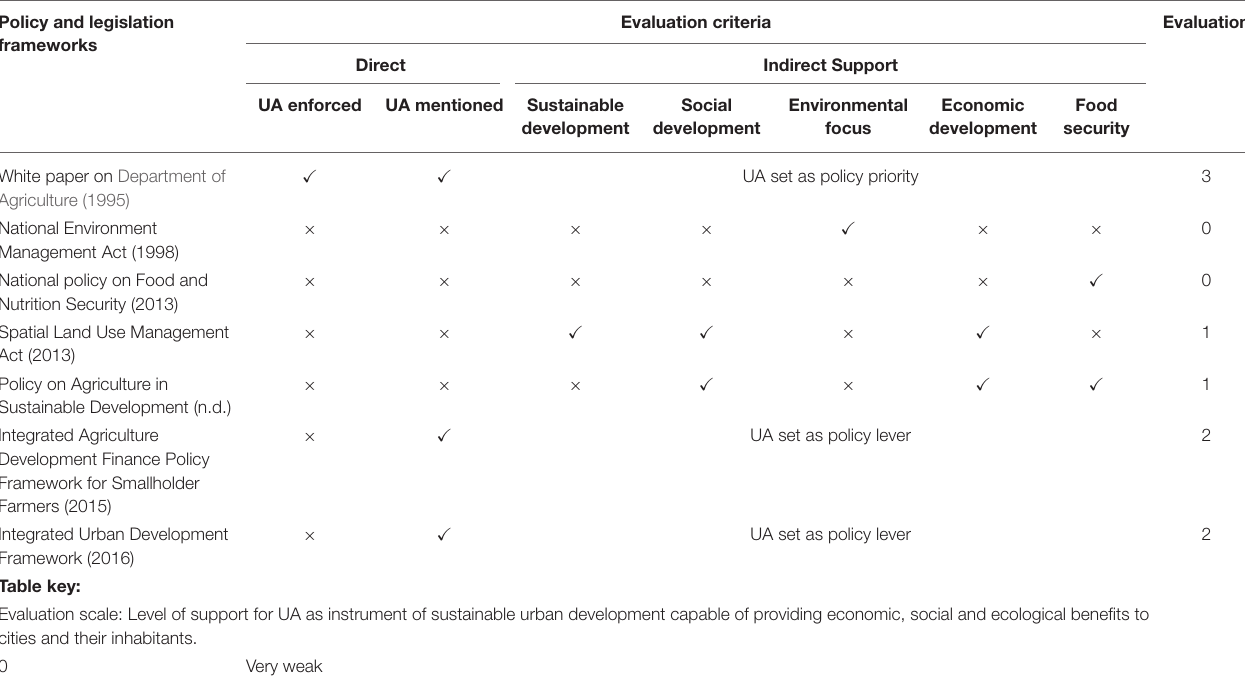
TABLE 4 | Policy and legislative matrix applicable to the two selected case studies in South Africa. Policy and legislation frameworks